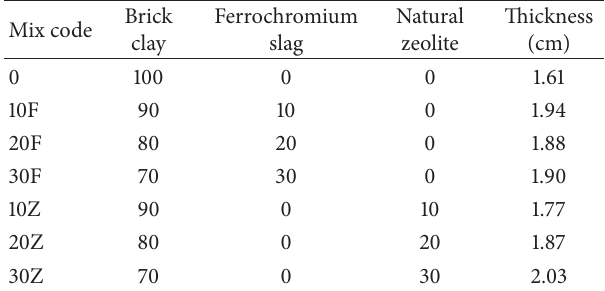
Table 1: Chemical composition of the raw materials used. Compositions Ferrochromium Brick clay Natural zeolite (wt.%) slag